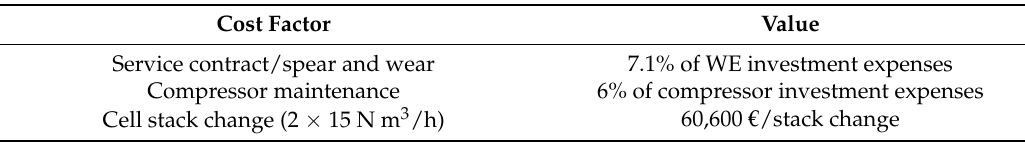
Table 2. Fixed annual operational expenses.